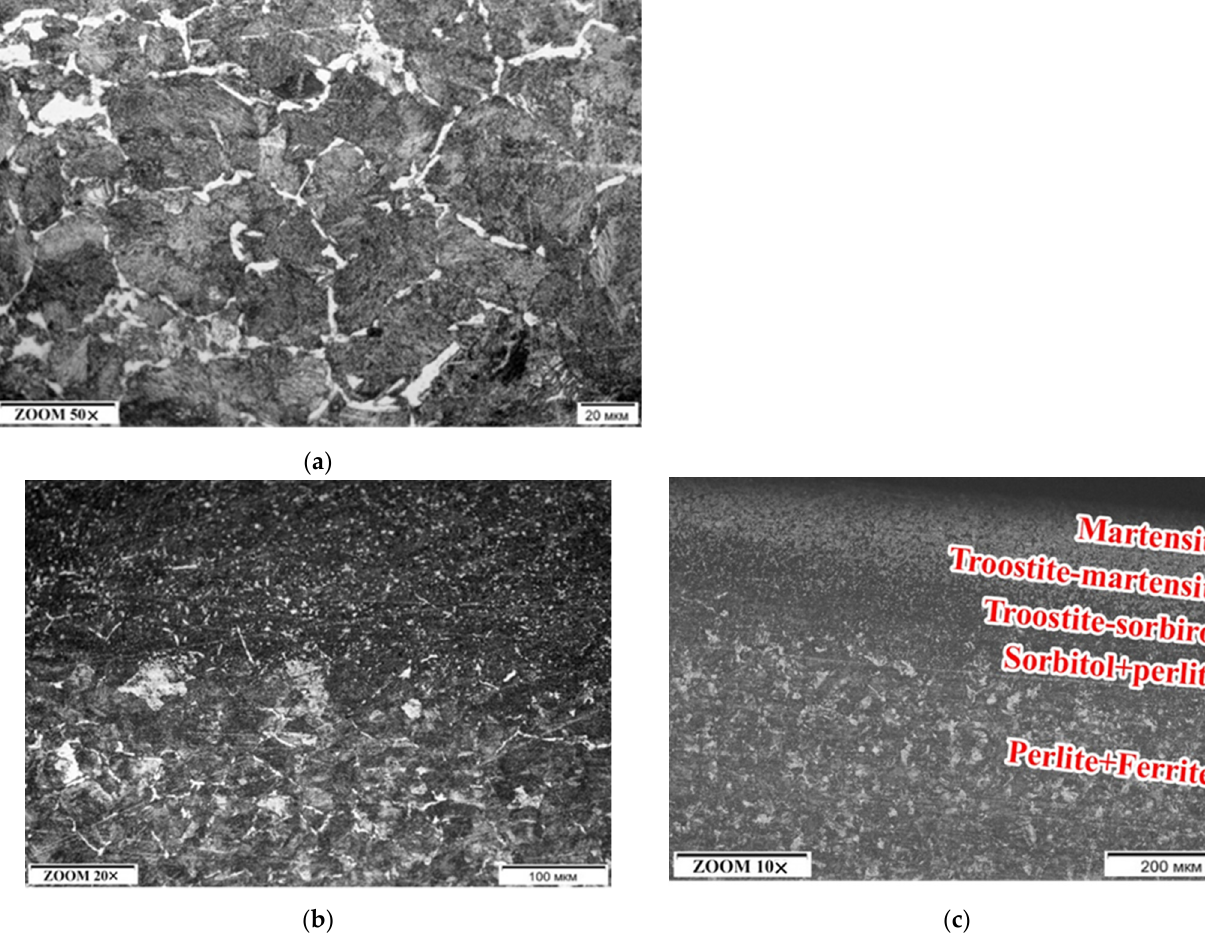
Figure 4. The steel structure: ( a ) non-hardened surface; ( b ) surface hardened without additional treatments; ( c ) surface preliminarily cleaned from surface marks (rust, scratches, etc.) using a grinding machine before hardening. Table 4. Hardness measurement results and calculated average values of indicators on the HRC scale.